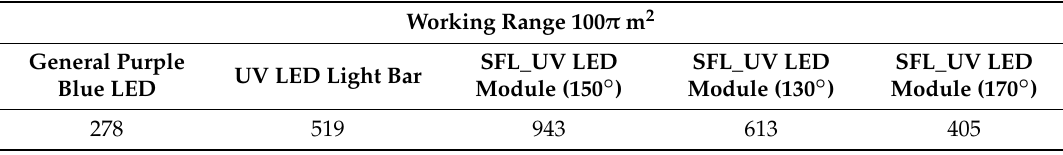
Table 1. Numbers of trapped mosquitos with different kinds of LED modules in the